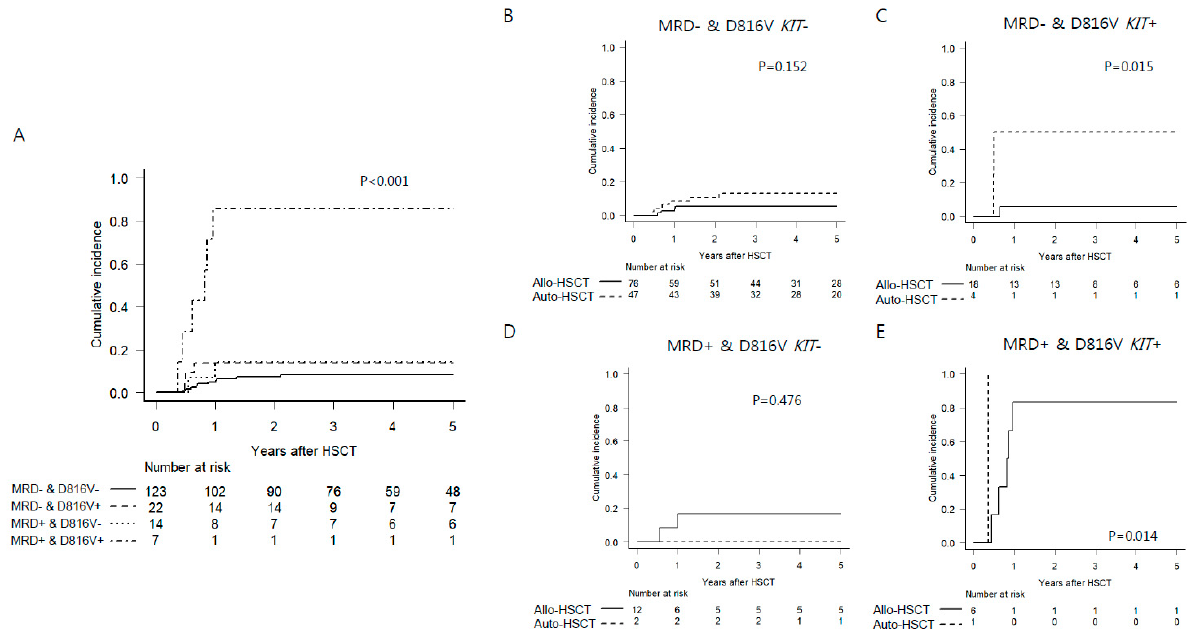
Figure 4. Cumulative incidence of relapse (CIR) according to both D816V KIT mutation and MRD positivity defined by 3 log reduction in RUNX1–RUNX1T1 levels at pre-HSCT ( A ) and effects of transplant types on CIR in each stratified group ( B – E ).